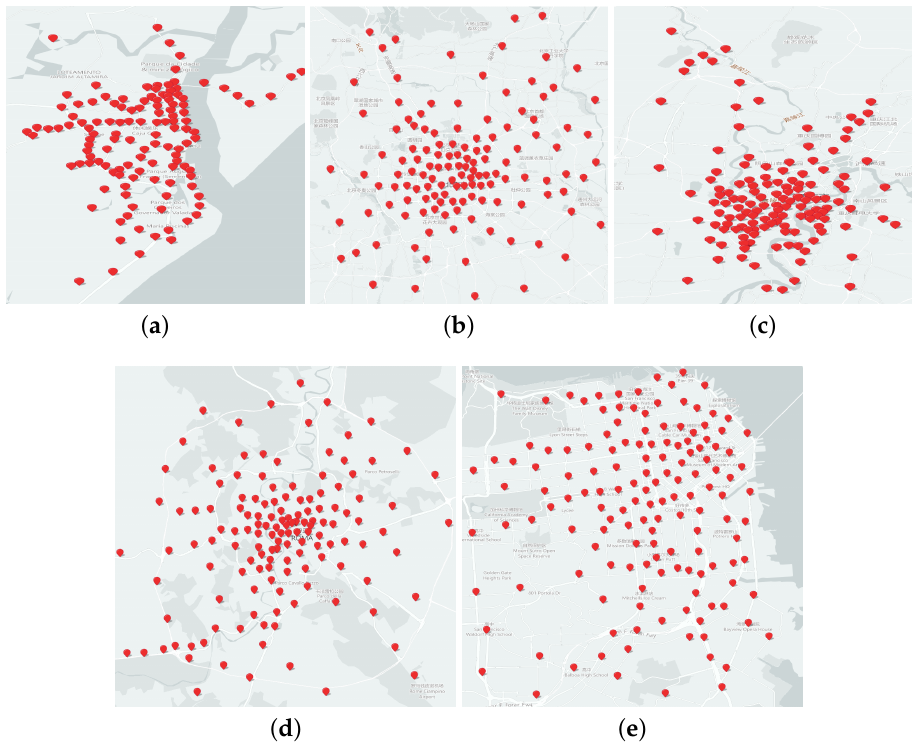
Figure 19. The urban hotspots captured by the novel FPSO-GAK algorithm. ( a ) Aracaju; ( b ) Beijing; ( c ) Chongqing; ( d ) Roma; ( e ) San